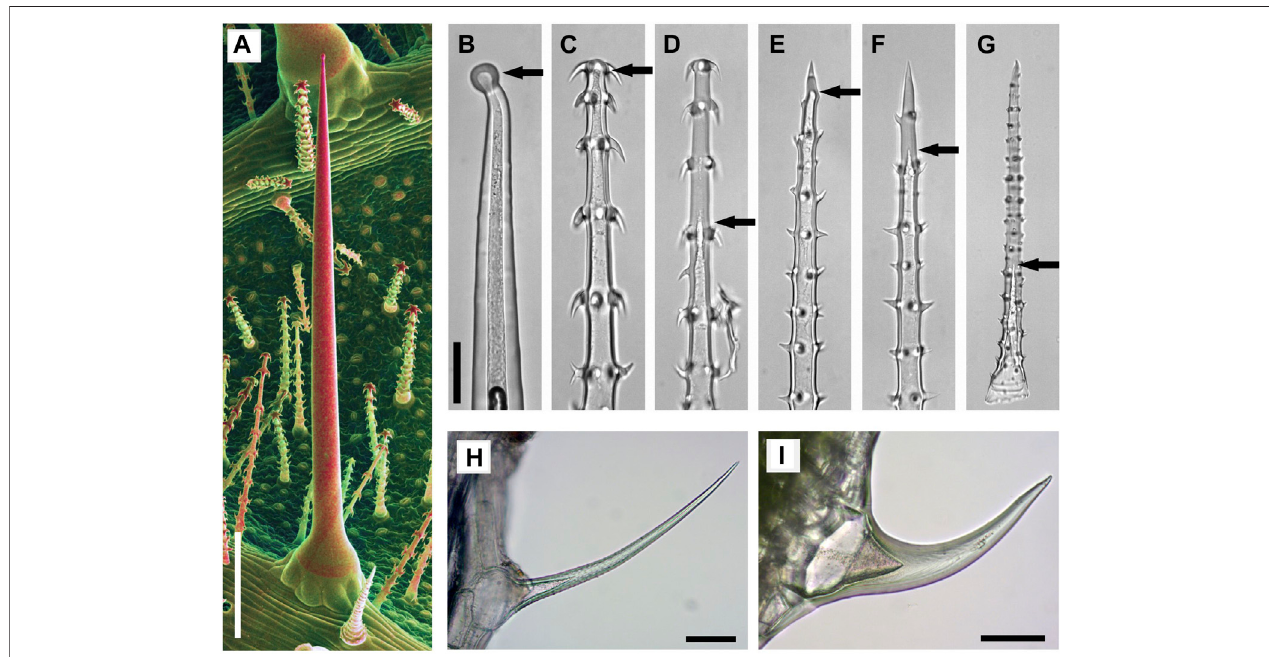
FIGURE 2 | Mineralized trichomes of Loasa pallida (A – G) , Urtica dioica (H) , and Galium aparine (I) . (A) SEM image of leaf underside with stinging hair and small glochidiate trichomes. Combined topographic and compositional contrast images showing mineralized structures in red color. Light microscopic (LM) images of a stinging hair (B) , glochidiate trichomes (C – D) and scabrid trichomes (E – G) . Stinging hairs and young stages of scabrid-glochidiate trichomes are hollow; they later become massive by fi llings with mineral deposits (C , E , F) . Arrows indicate the end of hollow lumen. Small trichomes of U . dioica (H) and G . aparine (I) which are almost completely massive. Scale bars: A (cid:1) 500 μ m; B-G (cid:1) 50 μ m; H-I (cid:1) 100